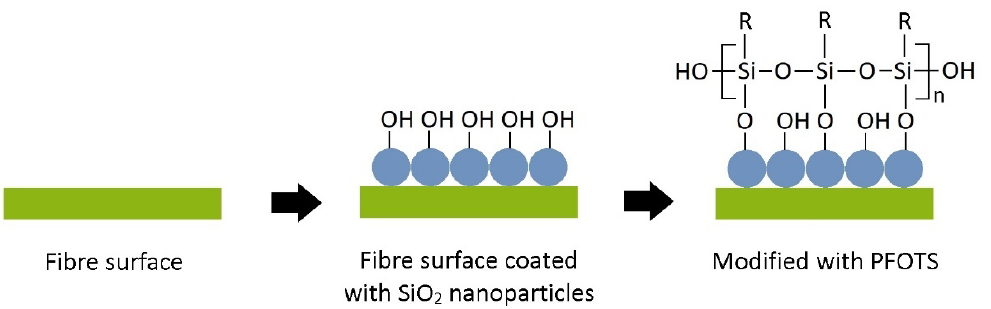
Figure 2. The schematic illusion of the treatment process to form a superhydrophobic STF surface. R represents the hydrophobic group of PFOTS: –CH 2 CH 2 (CF 2 ) 5 CF 3.